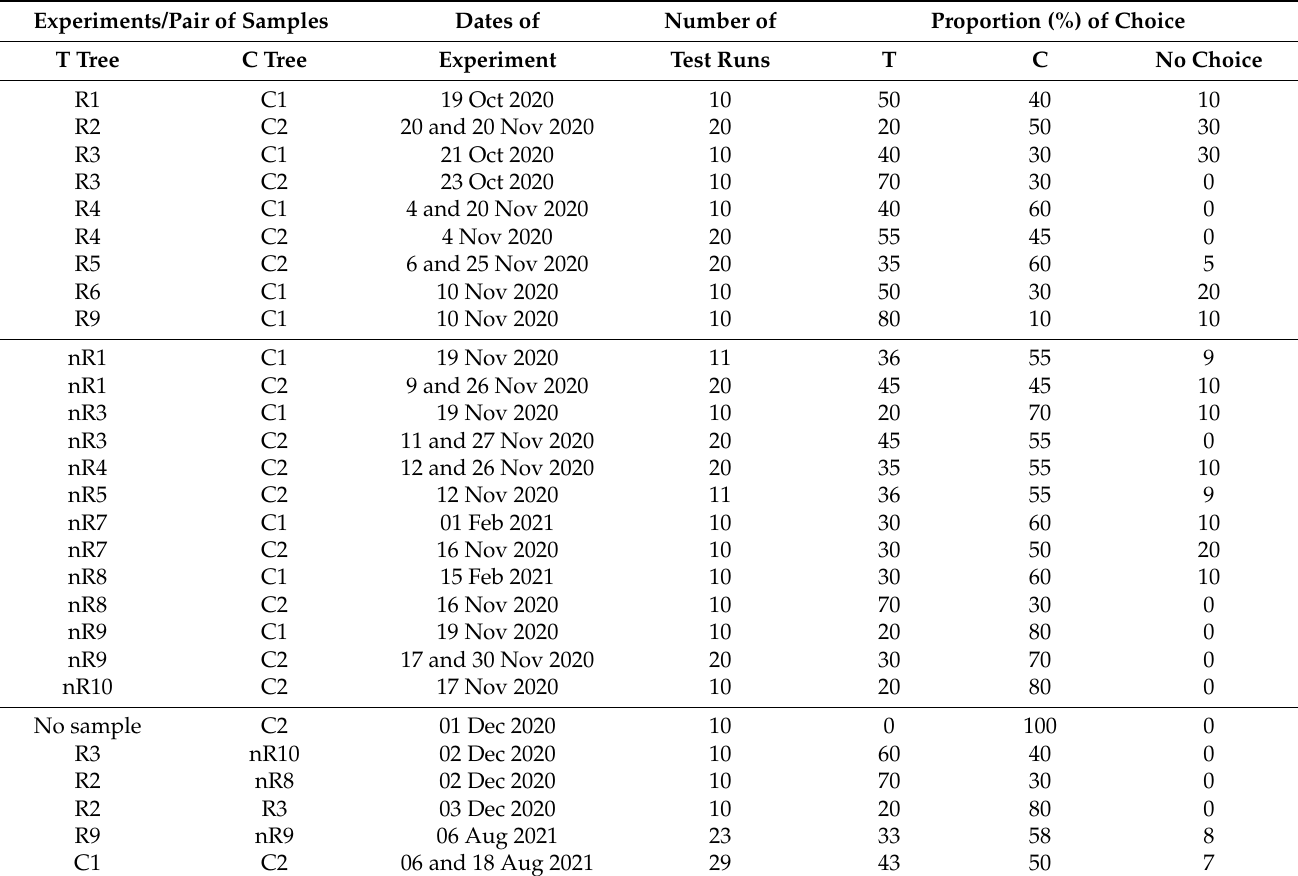
Table 1. Overview of Petri dish arena choice experiments: comparison of bark cores sampled from roofed (R), non-roofed (nR) and control (C) trees; dates of experiments and the number of test runs (replicates) per experiment; proportion of choices made by male Ips typographus (L.) across all test runs of an